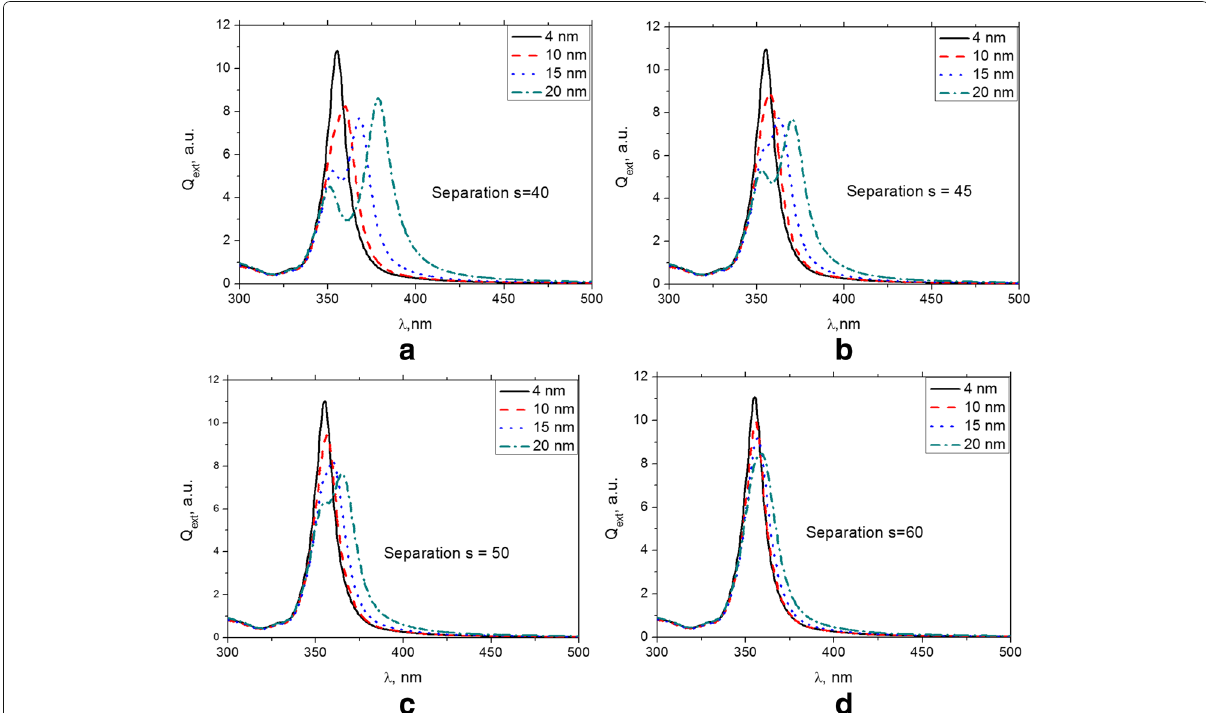
Fig. 4 The internal field enhancement spectra for four silver nanoparticle dimers with different radius ratios, at a fixed center-to-center separation a s = 40 nm, b s = 45 nm, c s = 50 nm, and d s = 60 nm. The radius of the small nanoparticle is varied while that of the large nanoparticle is kept constant at 20